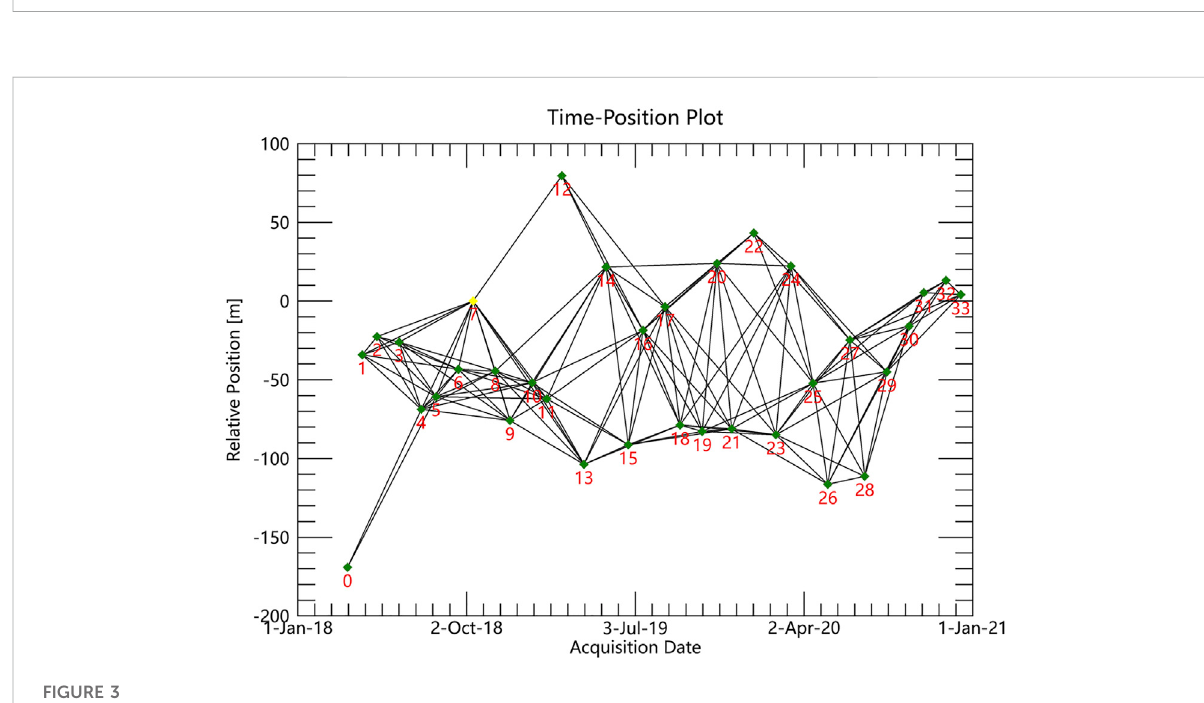
FIGURE 3 Time spatial baseline